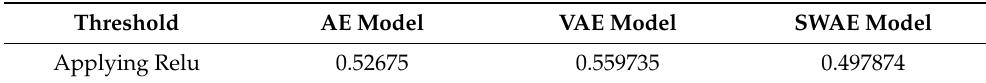
Table 6. Comparison of thresholds by